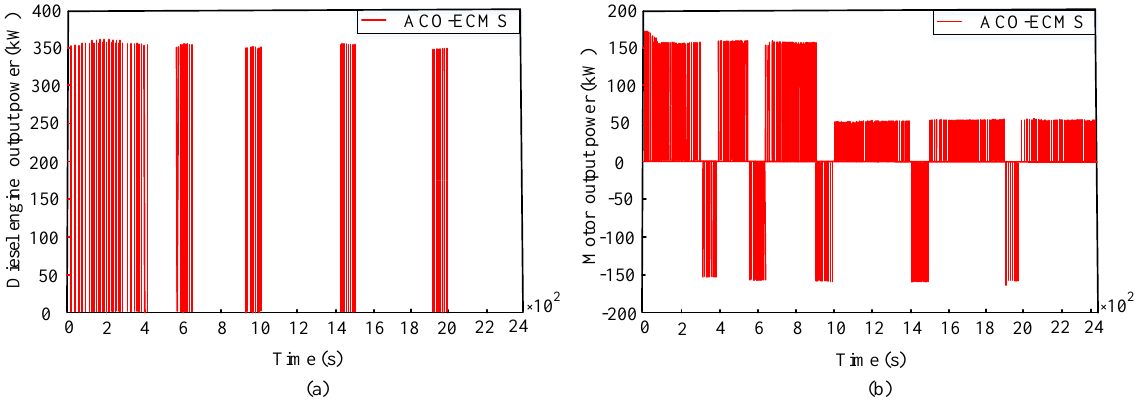
Figure 13. ( a ) Power distribution of the ant colony optimization (ACO)-ECMS strategy diesel engine under combined T conditions. ( b ) The motor power distribution of the PSO-DACO-ECMS strategy under T conditions.